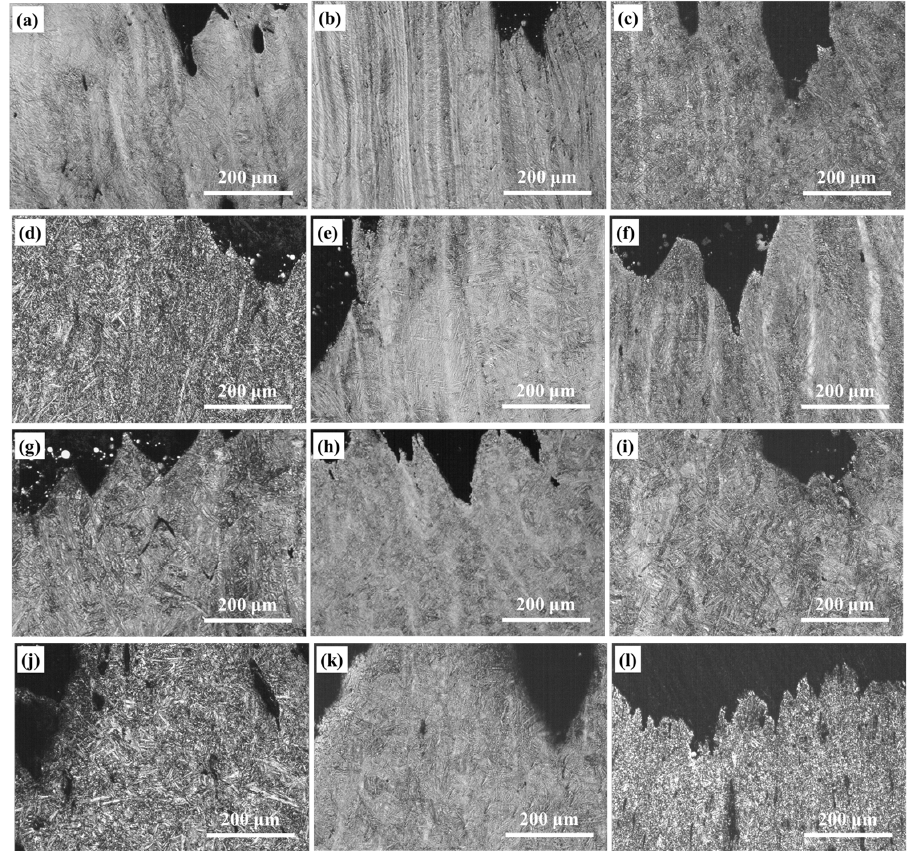
Figure 3. Optical microstructures near fracture tips of the specimens tested at different temperatures: